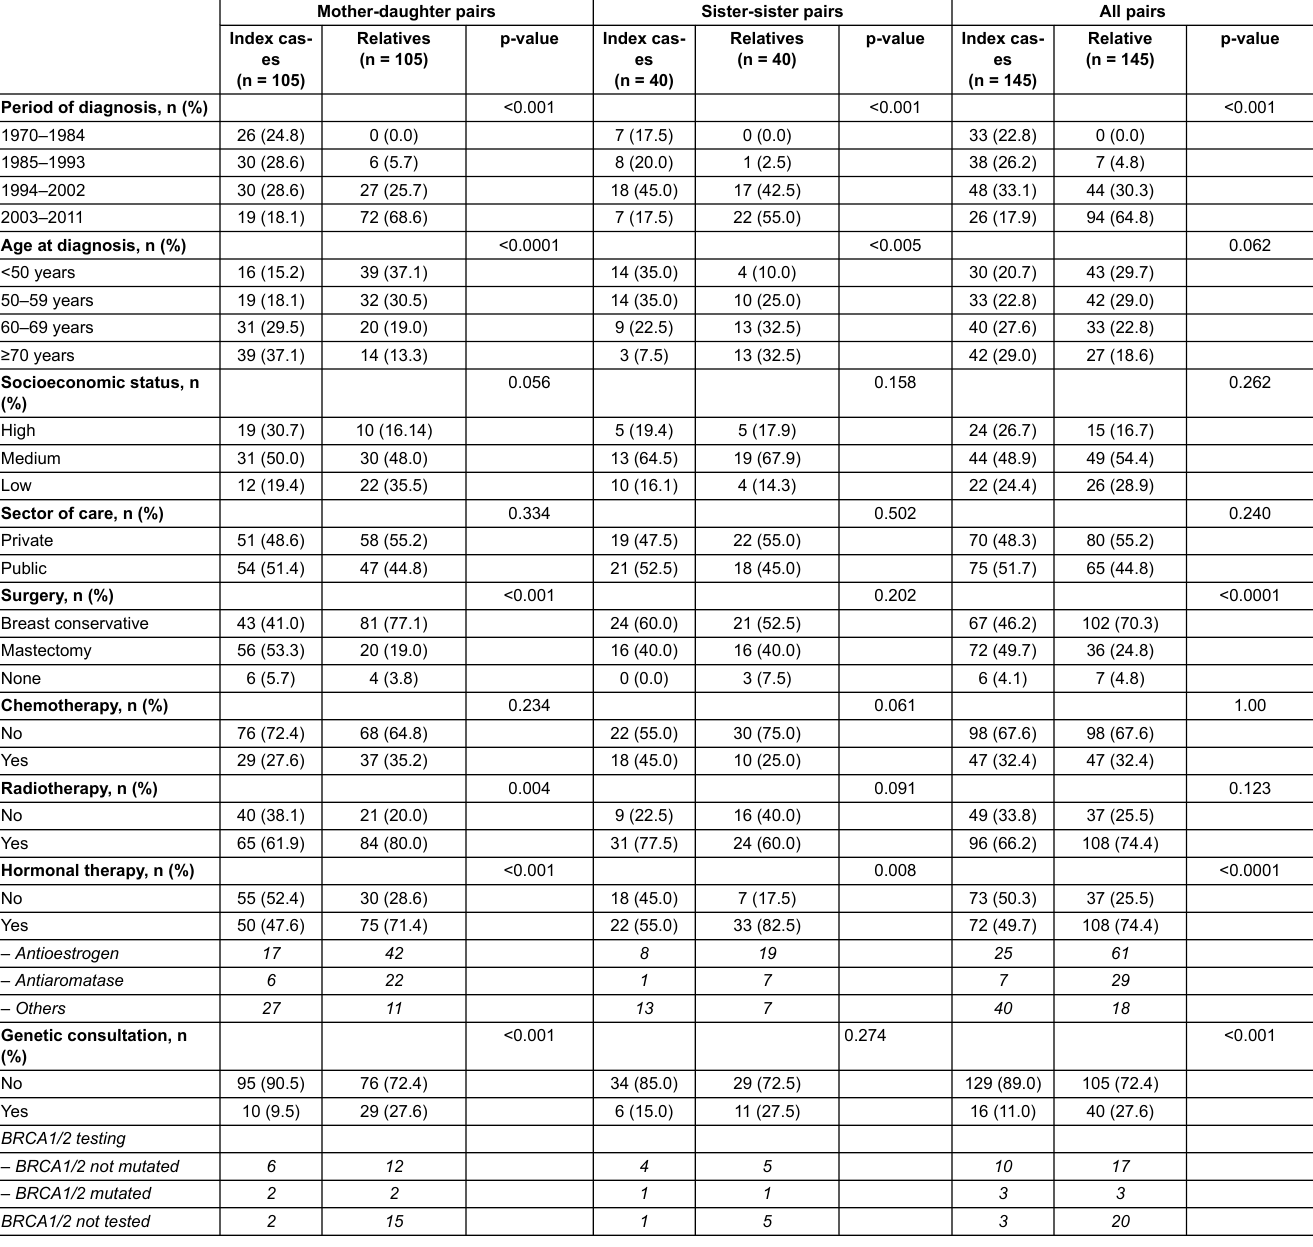
Table 1: Patient and treatment characteristics for mother-daughter, sister-sister and all pairs for the period 1970–2011, extracted from the Geneva Cancer Registry. Only pairs with known information for both index cases and relatives were considered. Mother-daughter pairs Sister-sister pairs All